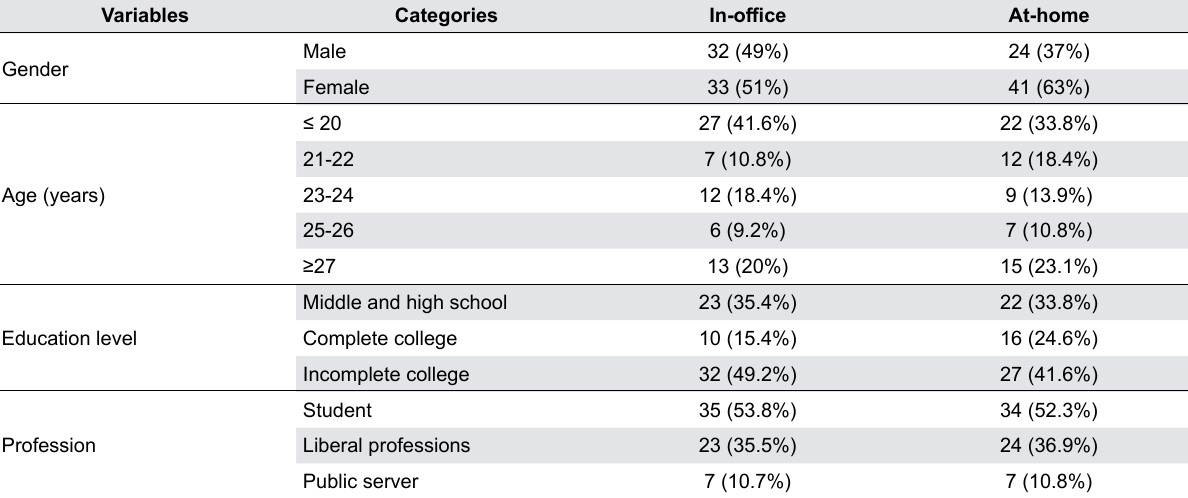
Table 2- Demographic characteristics according to the different treatment